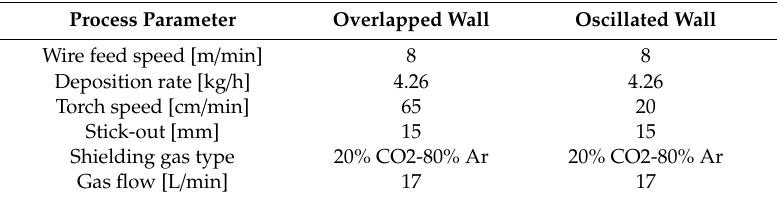
Table 3. Welding parameters for each